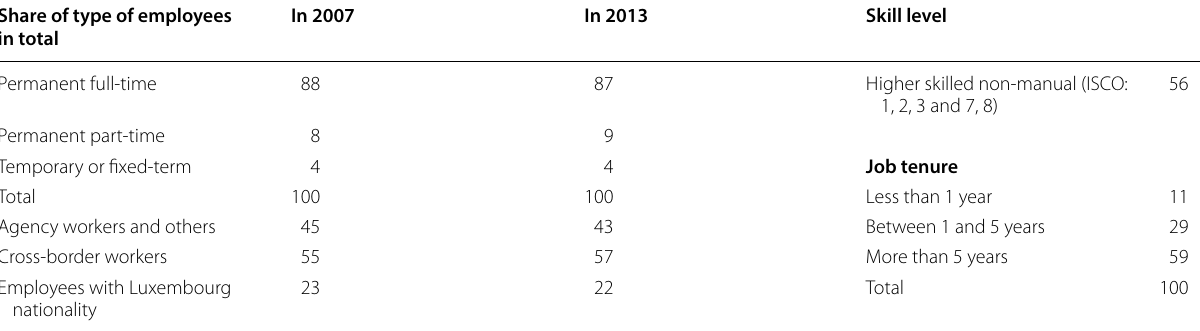
Table 2 Labour force characteristics (percent of firms) Share of type of employees in